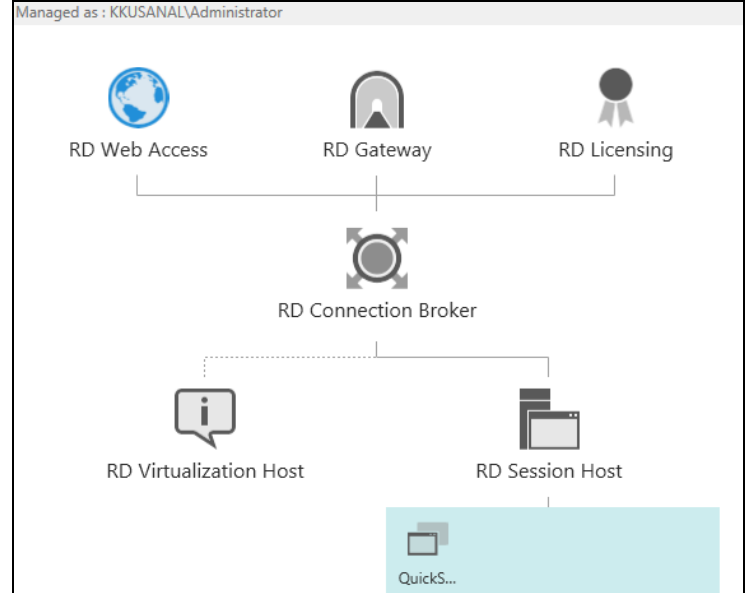
Figure 3. Laboratory system role schemes.